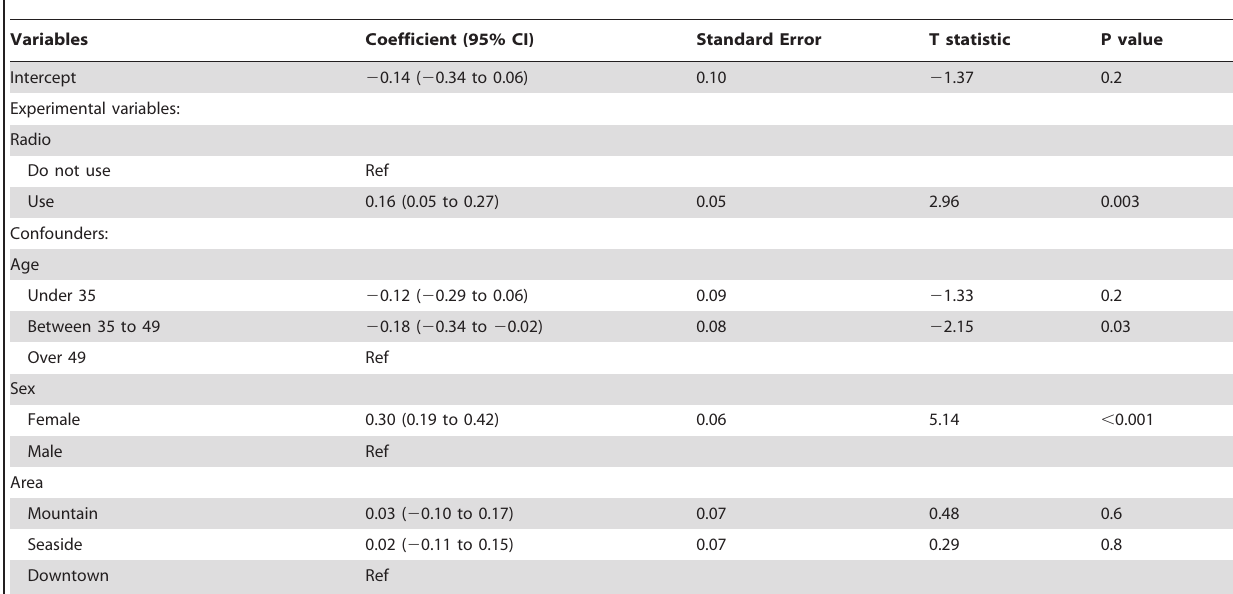
Table 5. Multiple regression model of factor three against the media